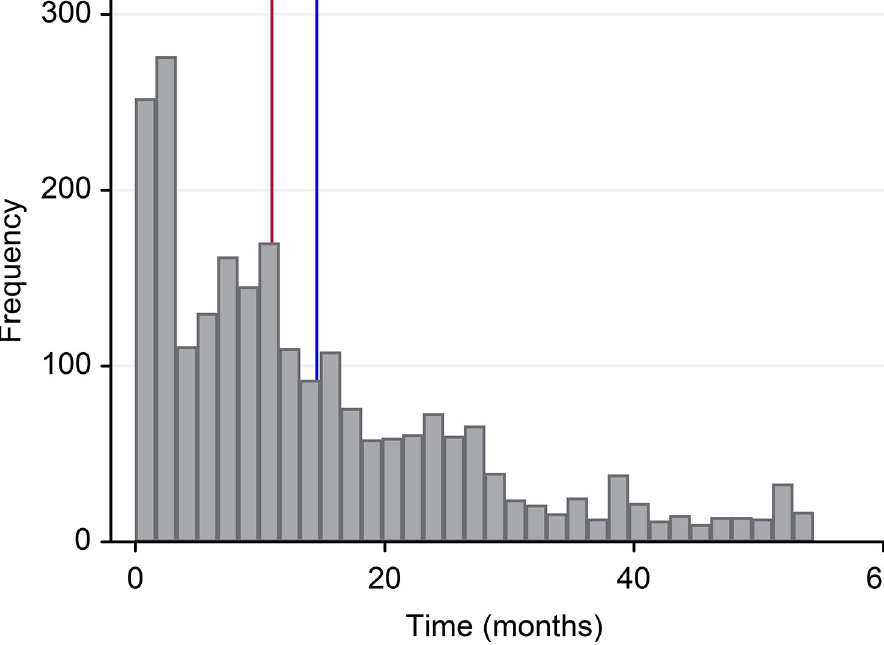
Fig 3. Length of tenure of physicians in PHC services (Red line = median (10.94), Blue line = mean (14.54); n =